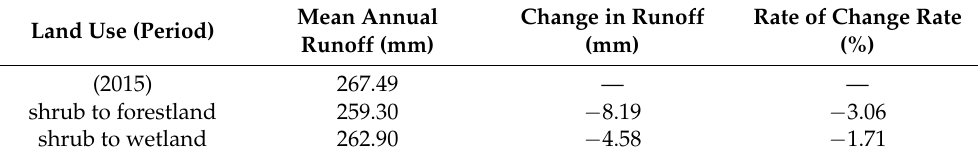
Table 6. Simulated annual mean runoff and its rate of change in future scenarios.